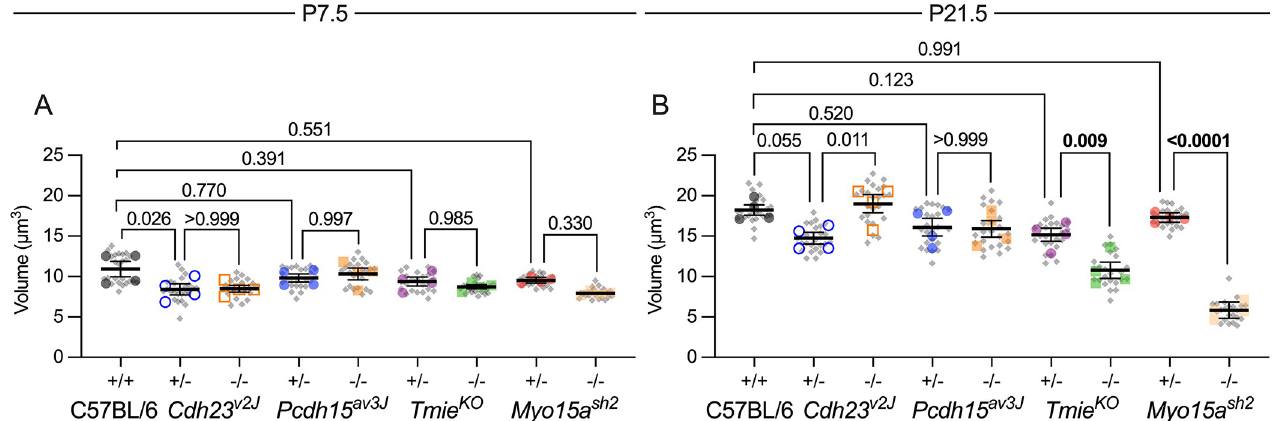
Fig 8. Total stereocilia volume in mutant IHCs. ( A, B ) Total stereocilia volume per hair bundle and volume CV for Cdh23 v2J , Pcdh15 av3J , Tmie KO , and Myo15a sh2 IHCs. Volume measurements used reconstructed stereocilia surfaces. Plotting was as in Fig 3; statistical tests used one-way ANOVA analysis with the Sˇida´k correction. ( A ) P7.5. No significant differences in volume between any of the genotypes. ( B ) P21.5. Modest differences in total stereocilia volume were seen for Cdh23 v2J /+ vs. Cdh23 v2J/v2J and Tmie KO /+ vs. Tmie KO/KO ; a large difference in volume was seen for Myo15a sh2 IHCs. The data underlying all the graphs shown in the figure can be found in figshare (https://doi.org/10.6084/m9.figshare.21632636.v2). CV, coefficient of variation; IHC, inner hair cell.